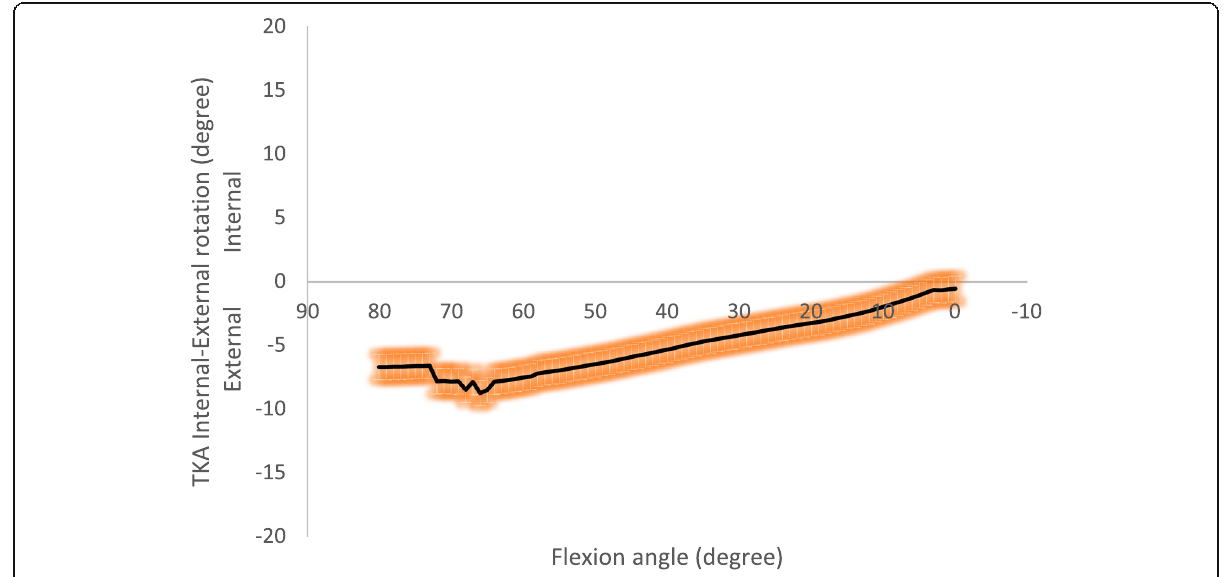
Fig. 4 Total knee arthroplasty Internal-External rotation (mean and standard